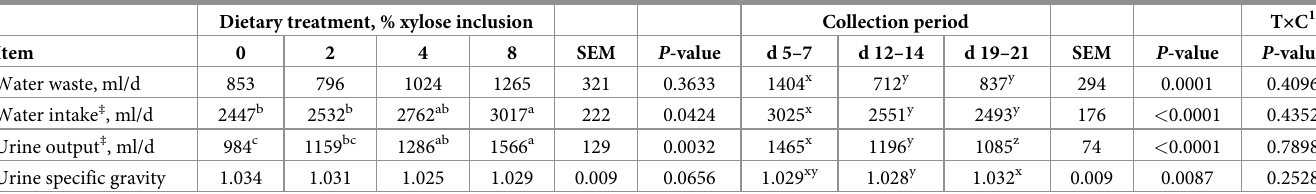
Table 4. Effect of dietary xylose concentration and collection period on water balance. Dietary treatment, % xylose inclusion